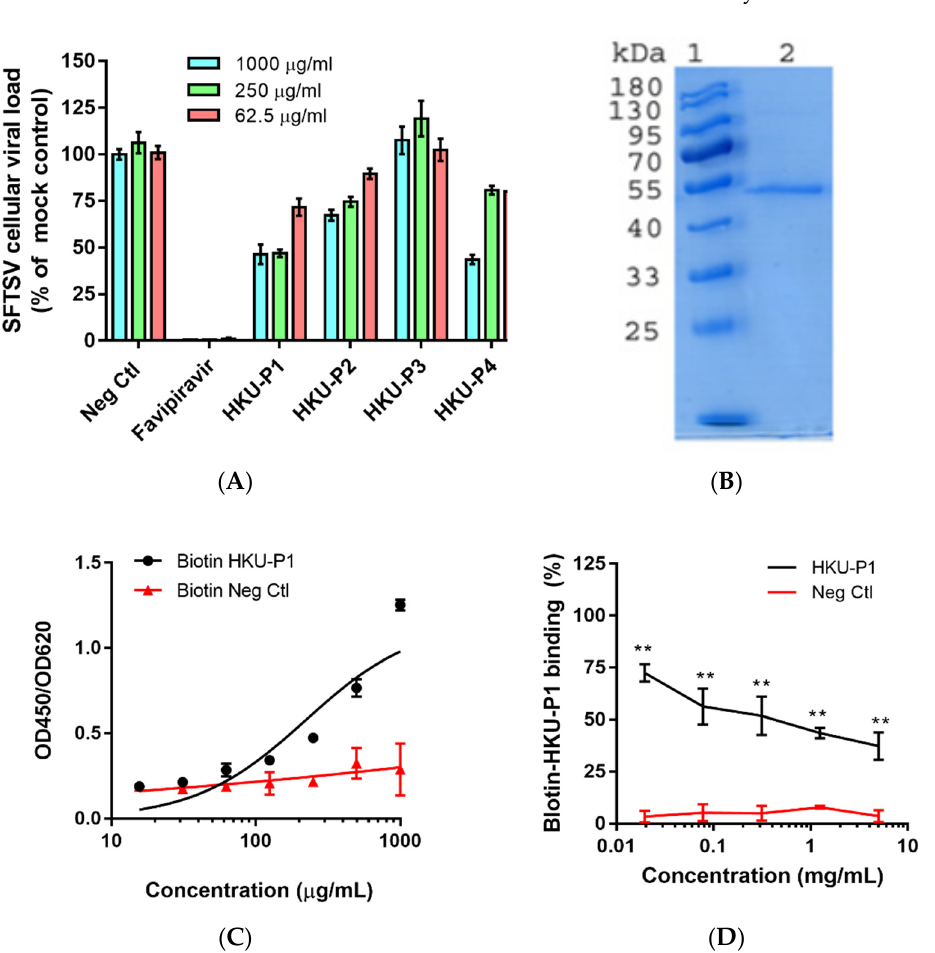
Figure 2. Evaluation of the cyclic peptides’ anti-SFTSV activity and HKU-P1 ′ s binding competition with the biotinylated cyclic peptide. ( A ) Anti-SFTSV activity of cyclic peptides HKU-P1 to HKU-P4. Out of the four peptides, HKU-P1, HKU-P2, and HKU-P4 displayed anti-SFTSV effects. ( B ) Sodium dodecyl sulfate-polyacrylamide gel electrophoresis showing the purity of His-tagged SFTSV Gn (lane 2). Lane 1 represents protein molecular weight marker. ( C ) Detection of the biotin-HKU-P1 binding to SFTSV Gn-coated immunoplate. ( D ) HKU-P1 inhibited the binding of biotin-HKU-P1 to the SFTSV Gn protein. ** p < 0.01 when compared the HKU-P1 and negative control peptide at each concentration by Student’s T -test.